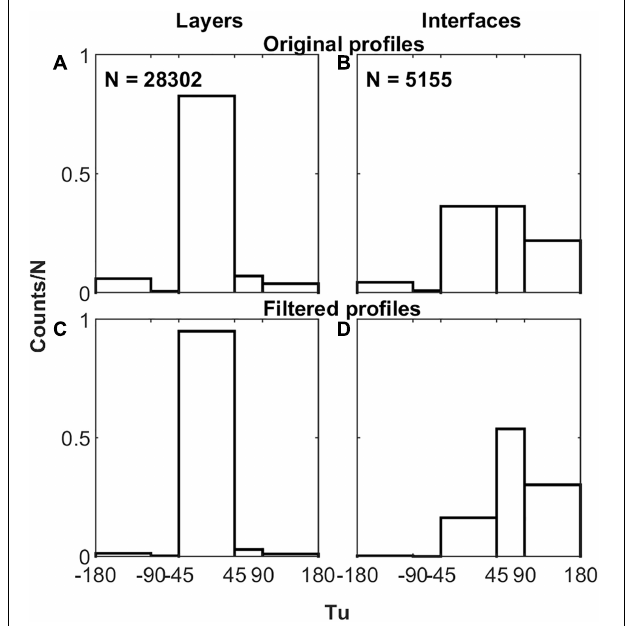
FIGURE 7 | (A,C) Histograms categorizing the density of observations in the layers extracted from the original and filtered profiles on the basis of the Turner angle. (B,D) The same, only this time for the interfaces instead of the